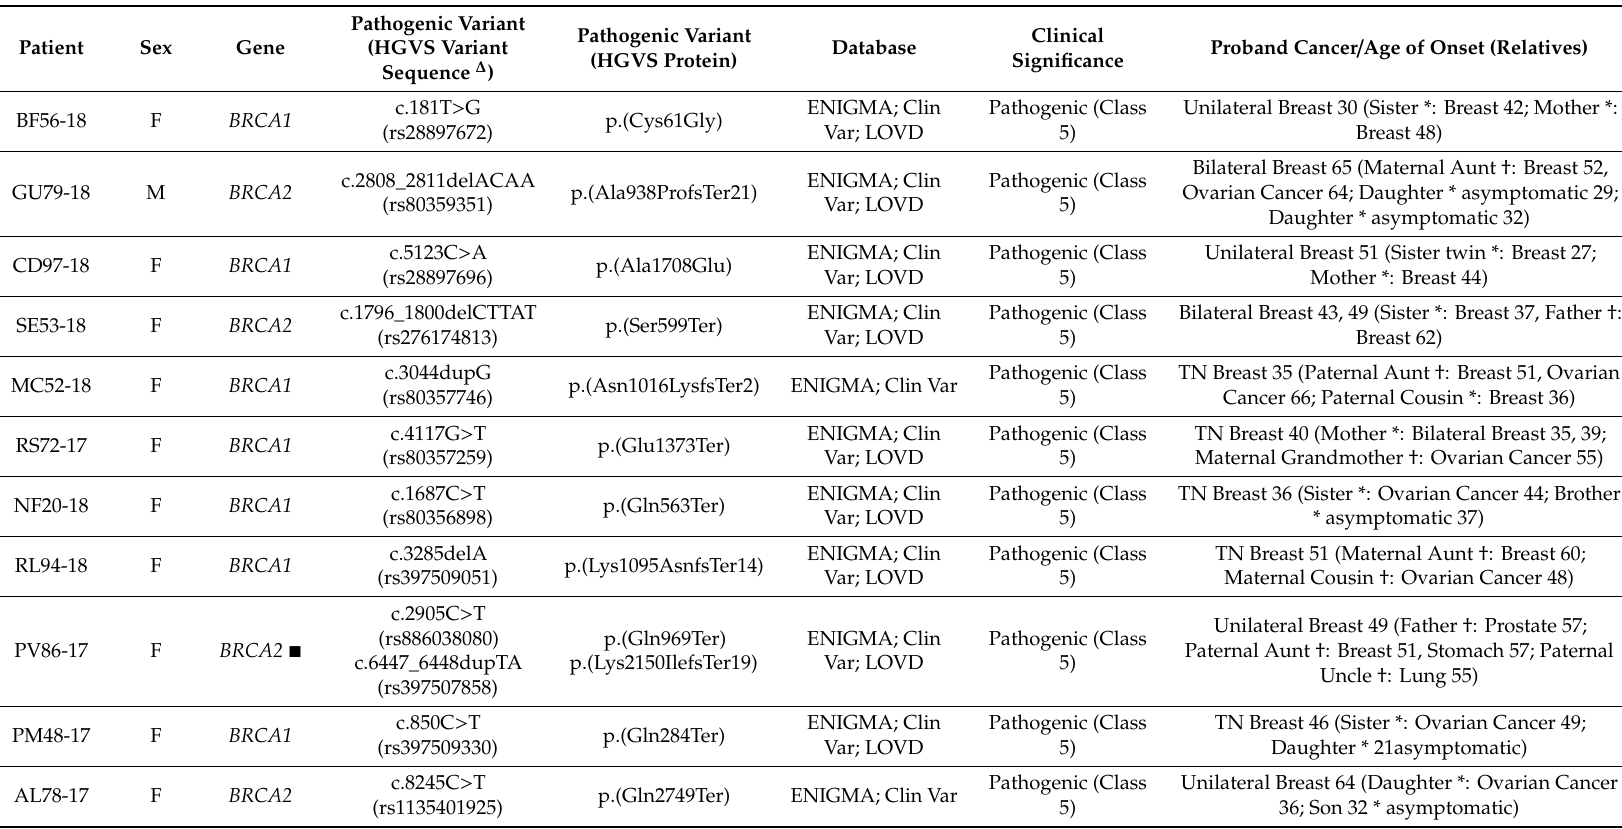
Table 1. BRCA1 and BRCA2 germline variants with assessed or unknown clinical significance detected in Italian patients with breast / ovarian